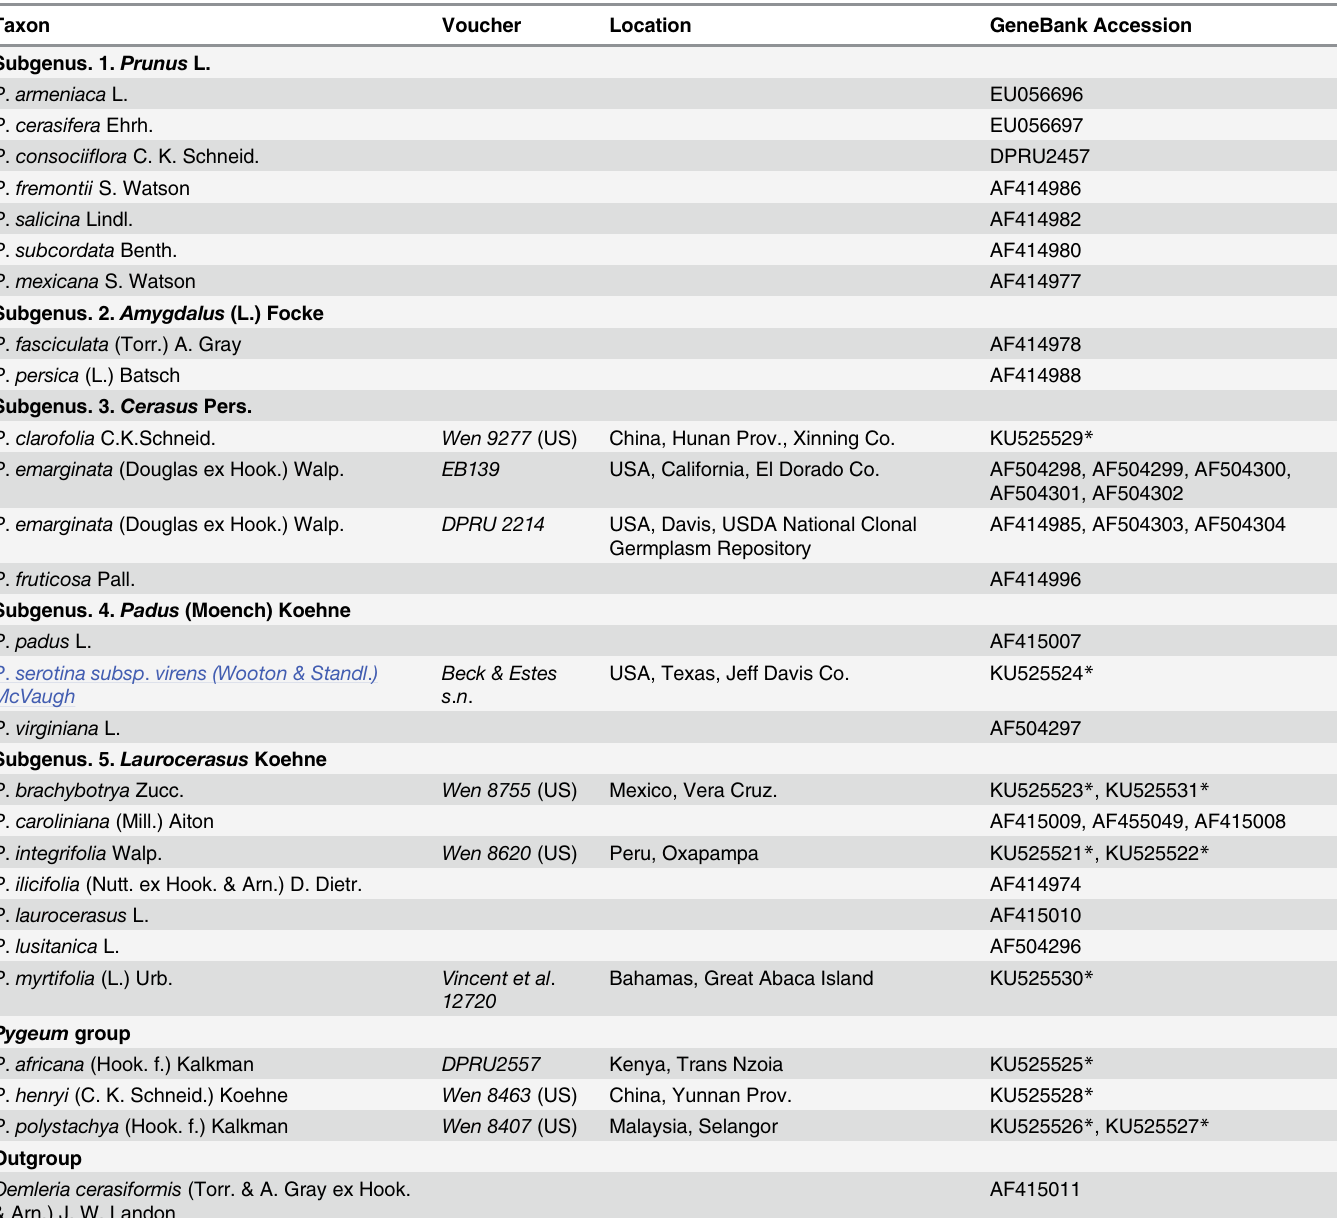
Table 4. Taxa and s6pdh gene GenBank accession numbers of Prunus and outgroups sampled for this study. All voucher specimens are deposited in the US National Herbarium (US) and and the Herbarium of University of California, Davis (DAV). Newly generated sequences are indicated by an